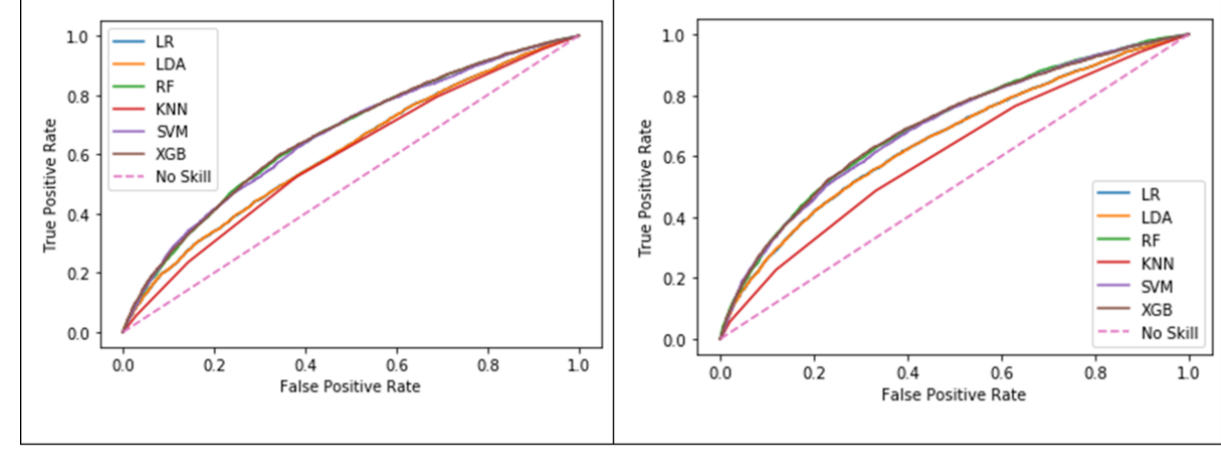
Test set AUROCTraining set AUROC, mean (SD)Method and algorithm